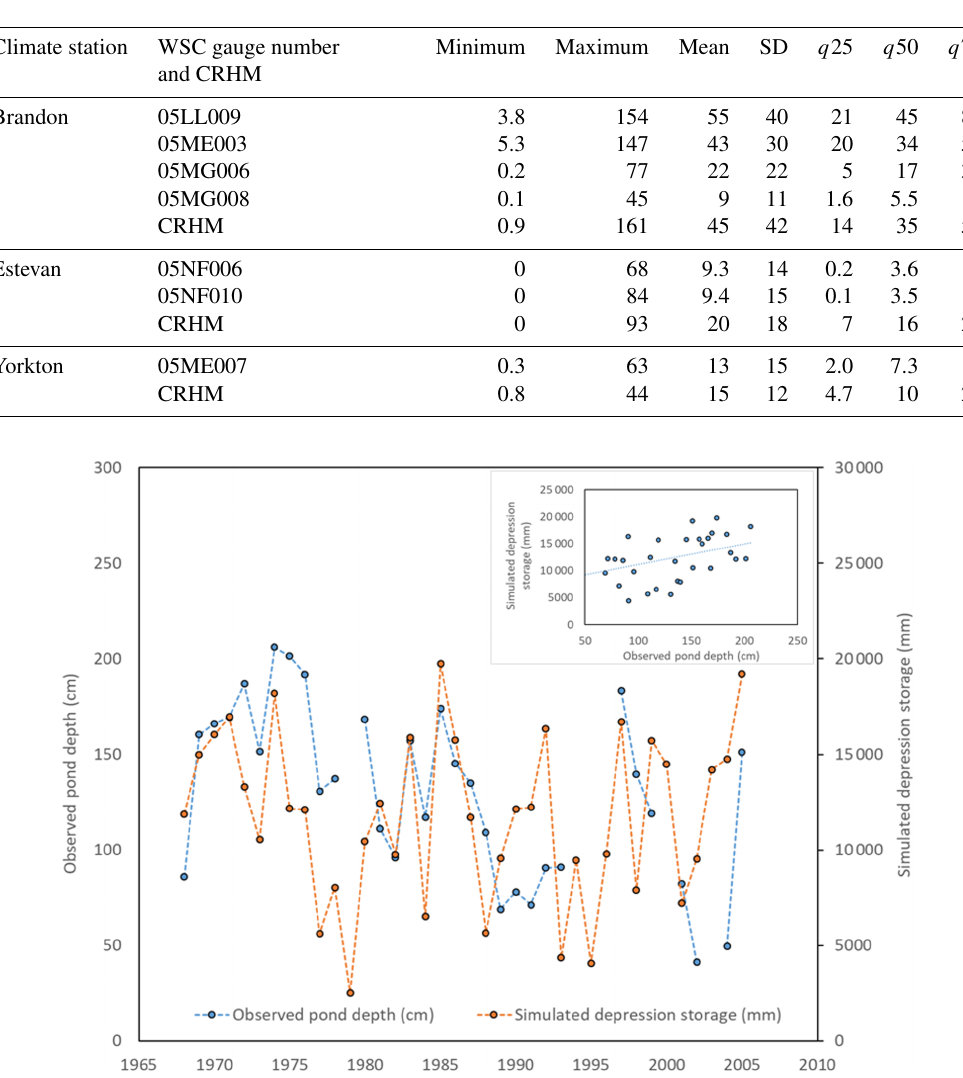
Figure 3. Annual average of observed depths in four ponds at the St. Denis NWA (blue line) and simulated depression storage in the virtual model for the 1968–2005 period (orange line). The inset illustrates the relationship between the two annual averages ( r = 0.42, p = 0.02, slope = 38.431, and intercept =